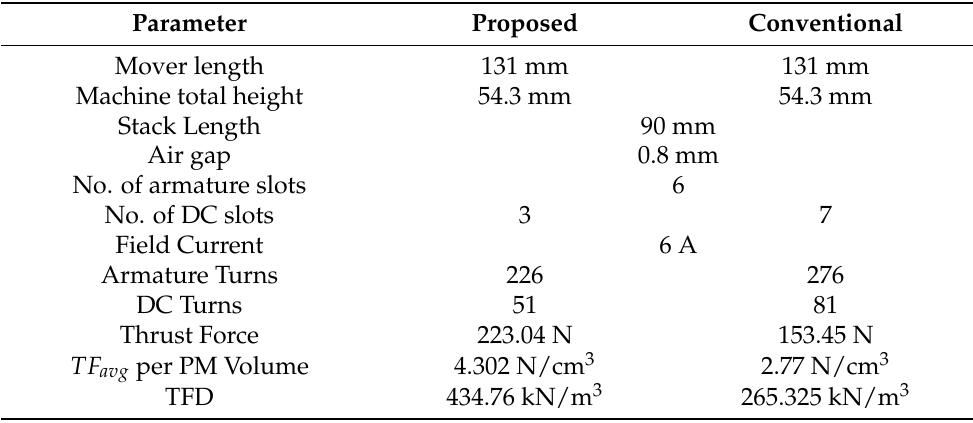
Table 5. Detailed comparison of the proposed and conventional